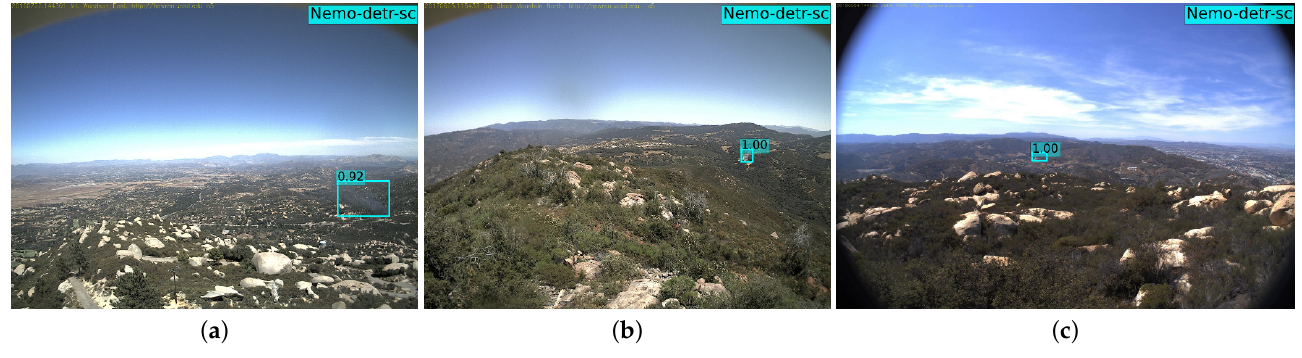
Figure 14. ( a ) 20160722_FIRE_mw-e was taken on 22 July 2016 at 14:43. ( b ) 20170625_BBM_bm-n was taken on 25 June 2017 at 11:54. ( c ) 20180504_FIRE_smer-tcs8 was taken on 4 May 2018 at 14:41.